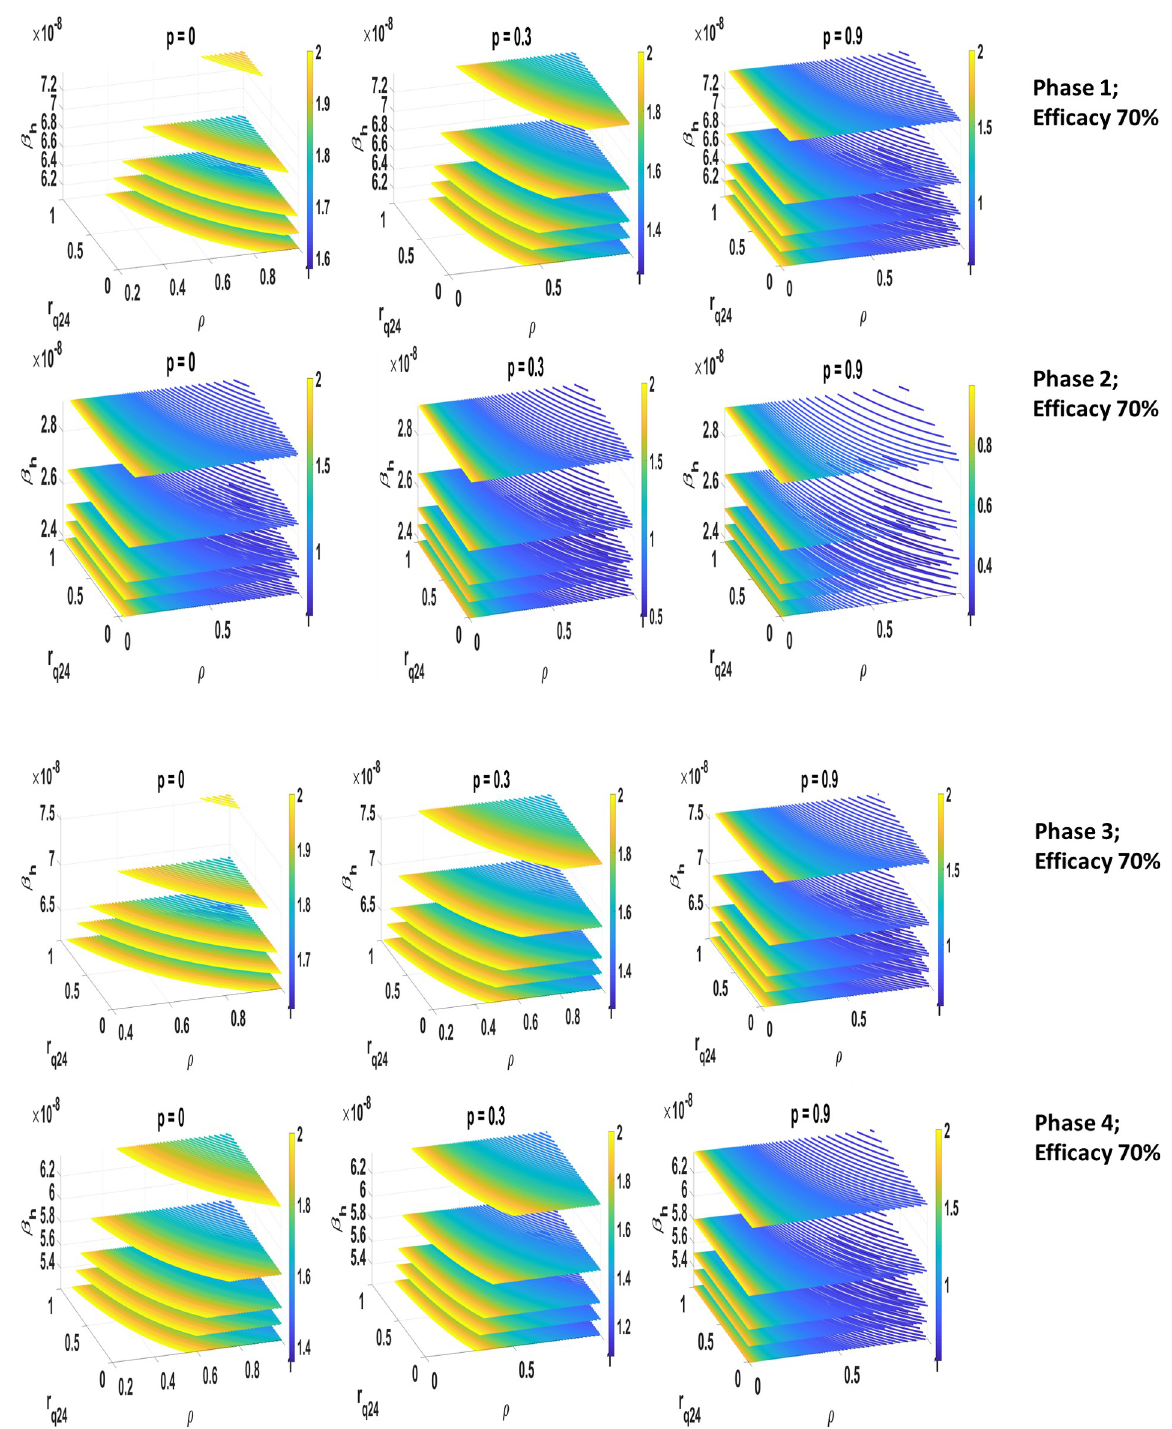
Fig 4. R 0 4D contour plot in the β h , r 24 , ρ parameters space. The values of the reproduction number are presented under Phase 1-2 and 3-4 (a, b, respectively) considering 0%, 30%,90% vaccine coverage, lifelong immunity and efficacy 70%. In all cases, we observe that as the vaccine coverage increases, the reproduction number decreases visibly. Also, the yellow region (indicating the highest values of the reproduction number) increases as the probability of the transmission in the household increases. In the phases with higher transmission (1, 3 and 4), we observe that the reproduction number is always greater than 1, except for 90% coverage. We also observe that if more people receive their test back within 24 hours, the reproduction number decreases. Similarly, in general, to maintain the reproduction number below 2, more than 20% of the infectious individuals need to be